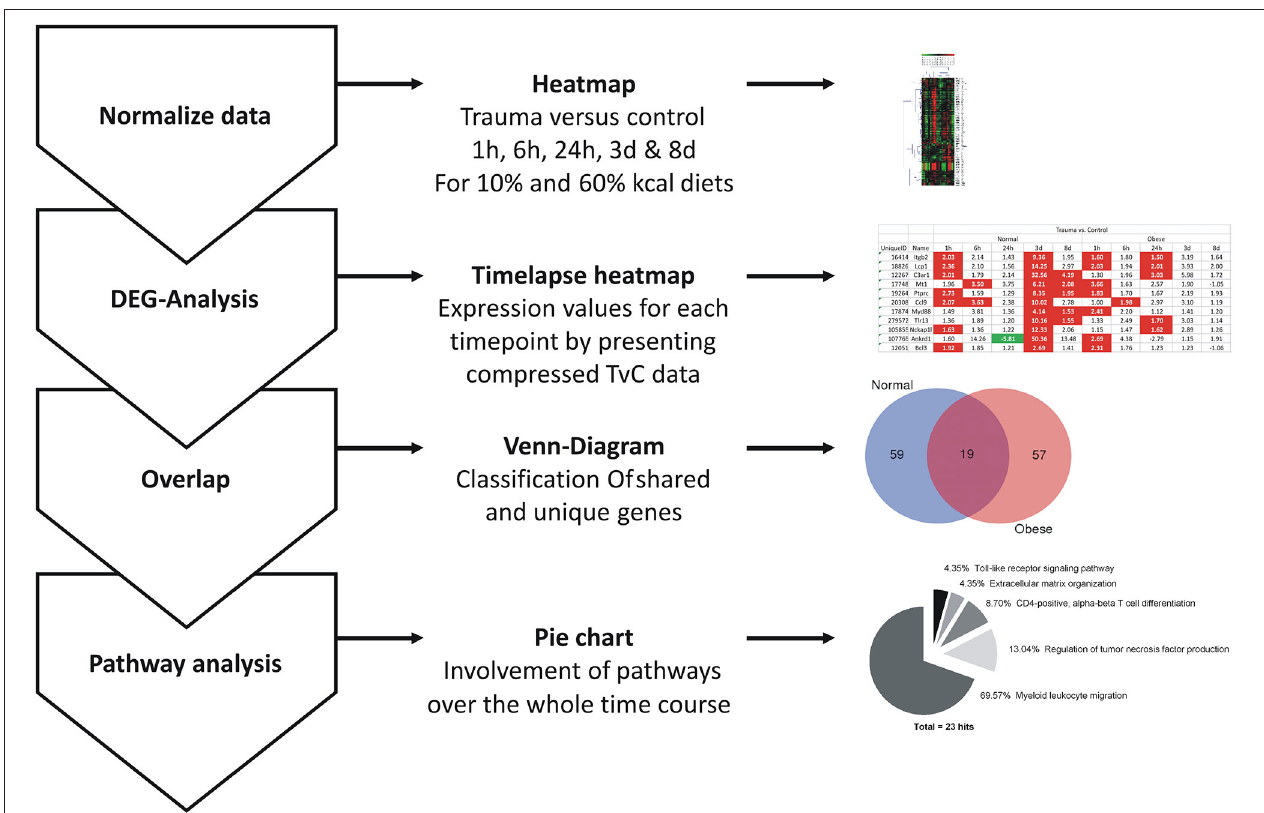
FIGURE 1 | General workflow for evaluation of present microarray data. After normalization of data and generation of heatmaps for each comparison, a general DEG analysis per time point and diet for the generation of a time-lapse heatmap was carried out. The total amount of genes for normal weight and obese mice at each time was compared to screen for unique and shared genes using Venn diagrams at the indicated time points. Final pathway analysis was carried out with ClueGO ( Bindea et al., 2009 ), a plugin for Cytoscape (Lotia et al.,